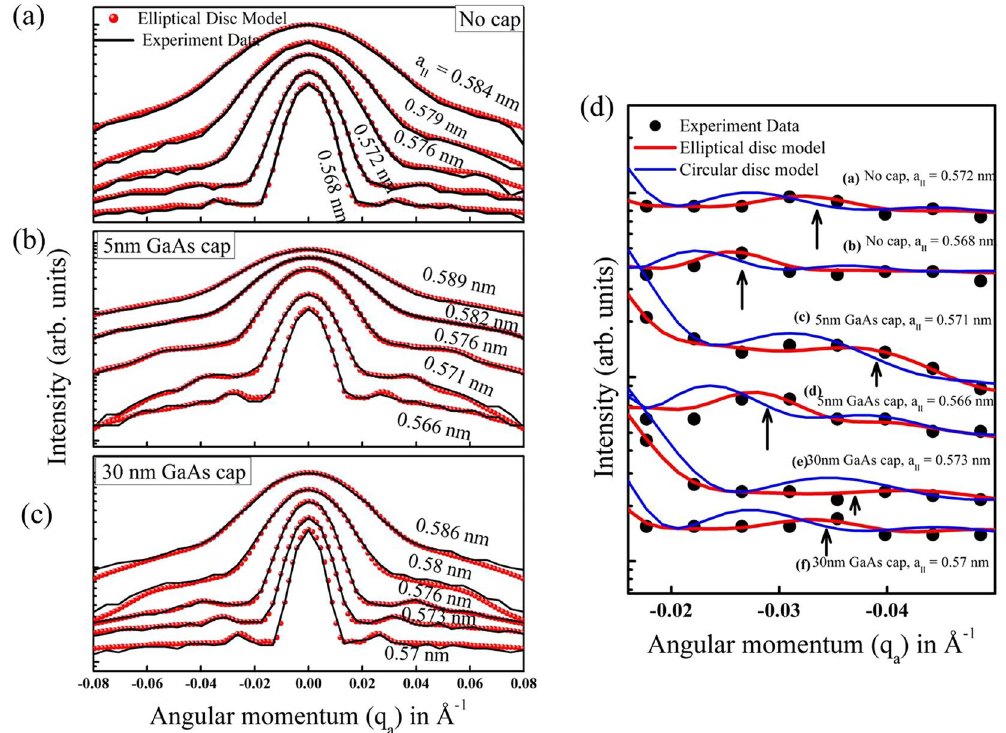
Figure 2. Angular scans (black lines) and fitted profiles (red lines) obtained from elliptical iso-strain disc model for ( a ) uncapped ( b ) 5 nm and ( c ) 30 nm capped QDs. ( d ) Measured angular scan data (black dot) and fitted profiles simulated from elliptical (red line) and circular (blue line) iso-strain disc model for ( a,b ) uncapped InGaAs QDs and ( c , d ) 5 nm and ( e , f ) 30 nm capped QDs.